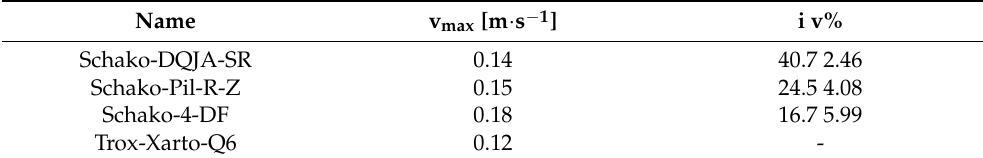
Table 1. Air volume flow rate (500 [m 3 ∙ h − 1 ]), velocity, and induction number for different diffusers.